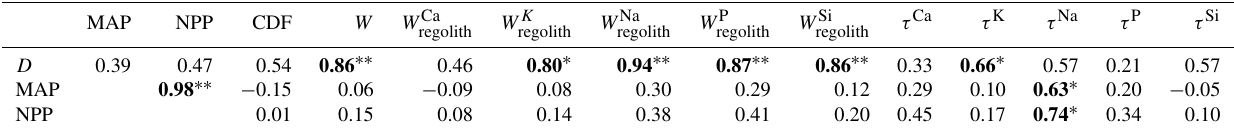
Table A4. Correlation matrix with Pearson’s correlation coefficients and significance ( ∗∗ : p< 0 . 01; ∗ : p< 0 . 05) for net primary productivity (NPP), denudation rate ( D ), mean annual precipitation (MAP), and indices of total and elemental degree and rate of weathering. Here we treat each regolith profile as independent, i.e., n = 8. Correlation coefficients involve the entire EarthShape study area. Bold numbers denote significant